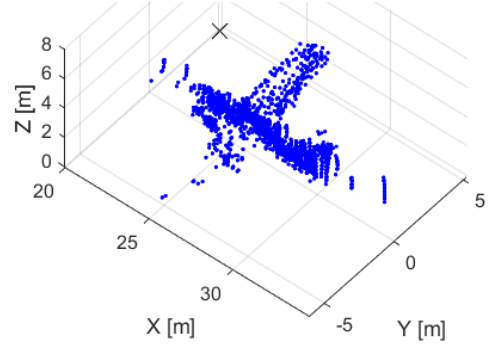
airplane points are shown in green, the reconstruction is in blue.